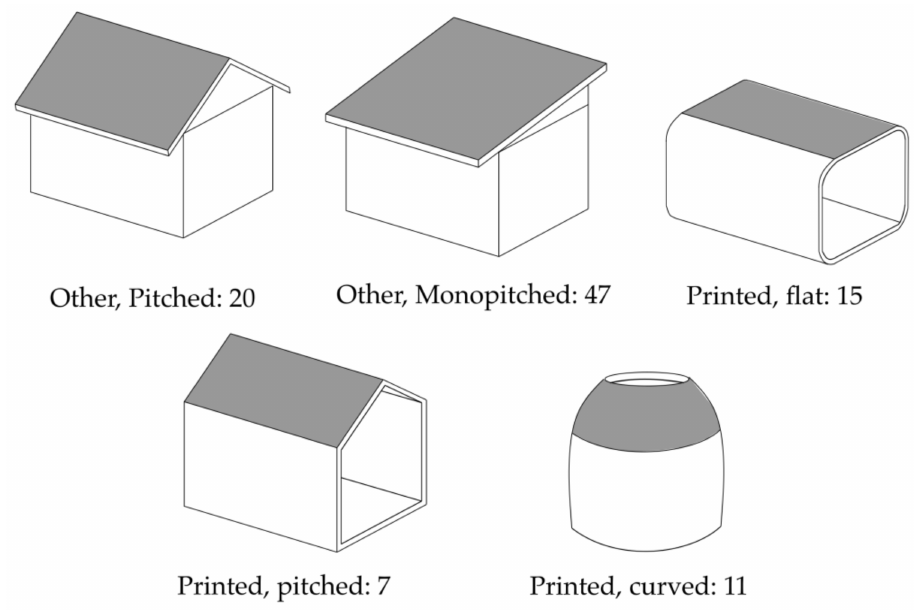
Figure 9. Types of roofs in the 3D-printed constructions